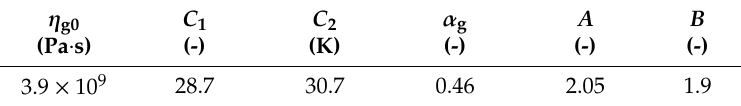
Table 3. Chemorheological parameters for the PRISM EP 2400